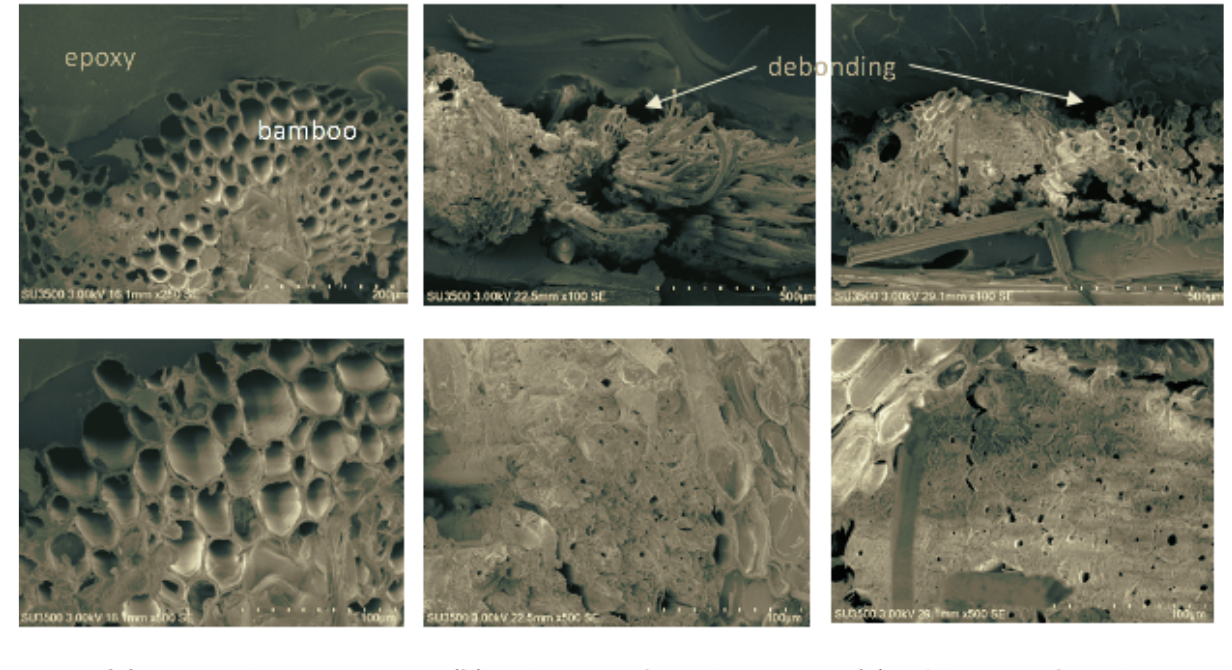
Figure 3: Scanning Electron Microscopy [15] photograph of the fractured specimens